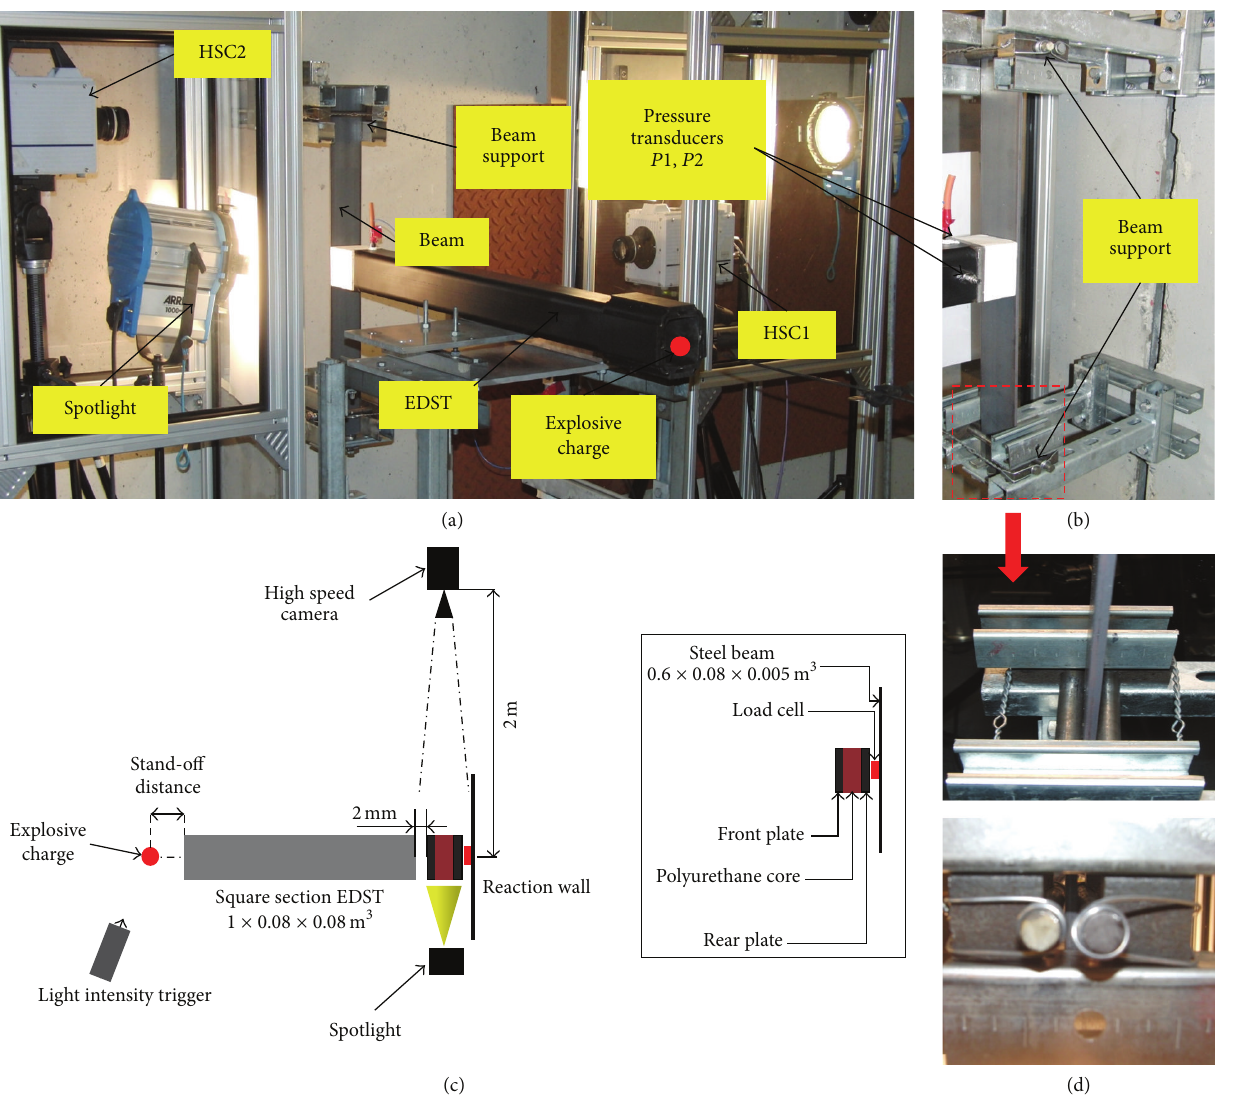
Figure 4: (a) Experimental setup, (b) beam support, (c) schematic representation of the experimental setup, and (d) simple support of the steel